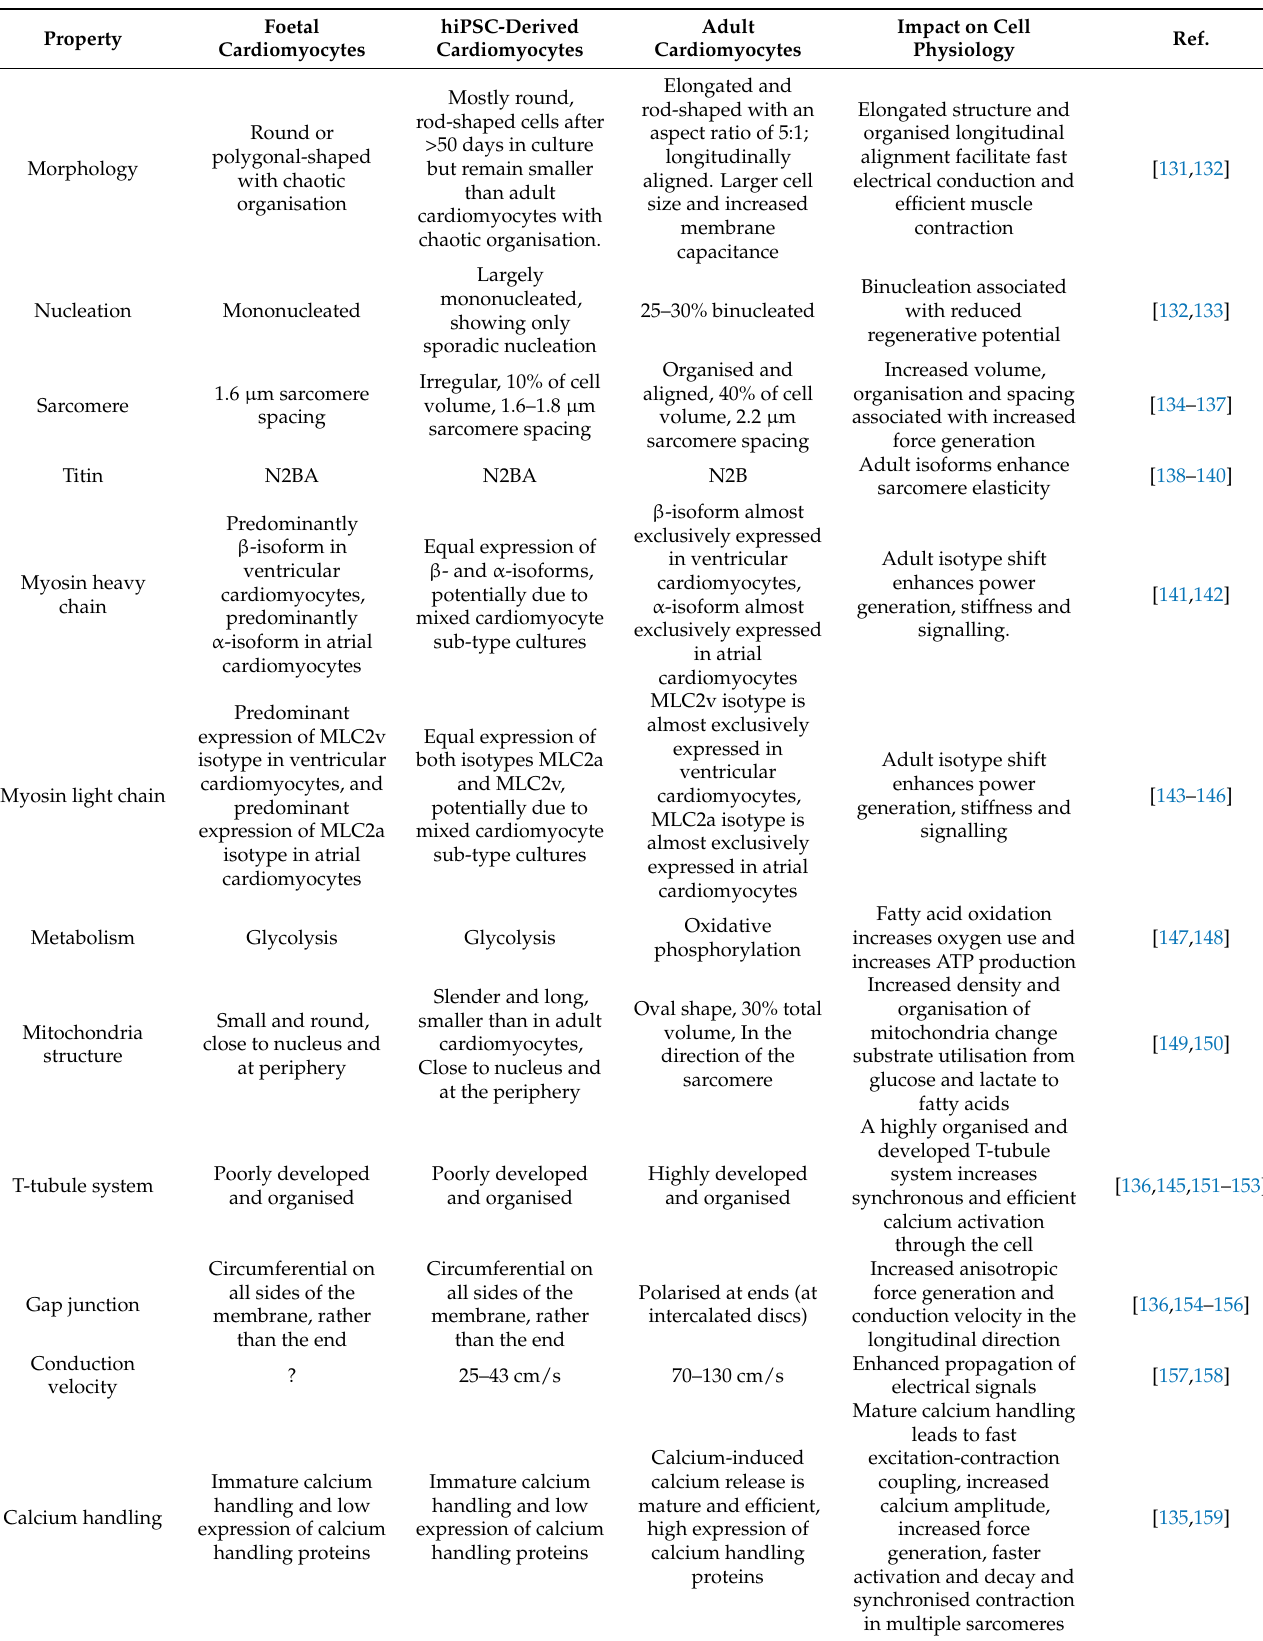
Table 2. Different properties of foetal, hiPSC-derived and adult